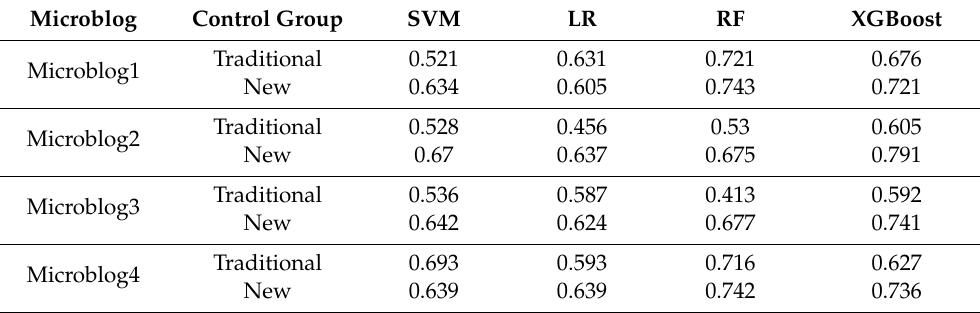
Table 4. F1 Scores of control group results for the four machine learning